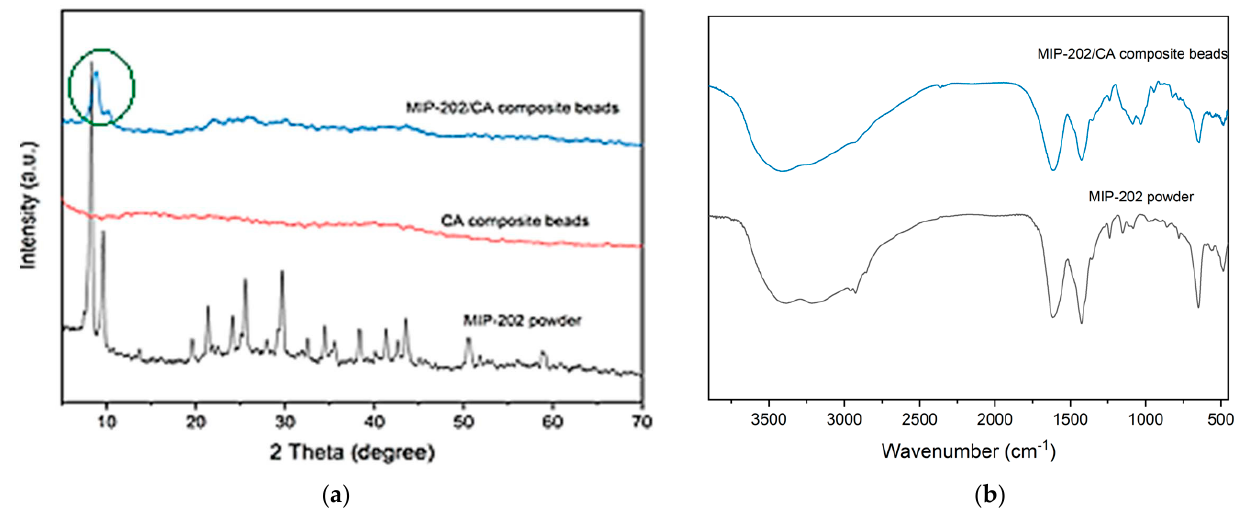
Figure 2. ( a ) Experimental PXRDs patterns of MIP-202 powder (black), chitosan-alginate composite beads (red), and MIP-202/CA composite beads (blue). ( b ) FTIR spectra of MIP-202 powder and MIP-202/CA composite beads.